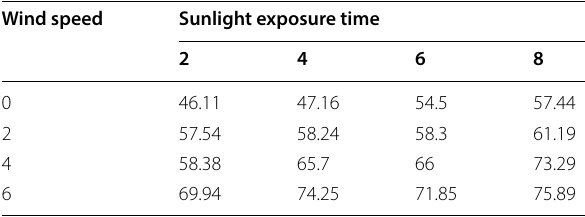
Table 6 Test results of concrete chloride diffusion coefficient rate ( 10 − 12 m 2 /s). ×